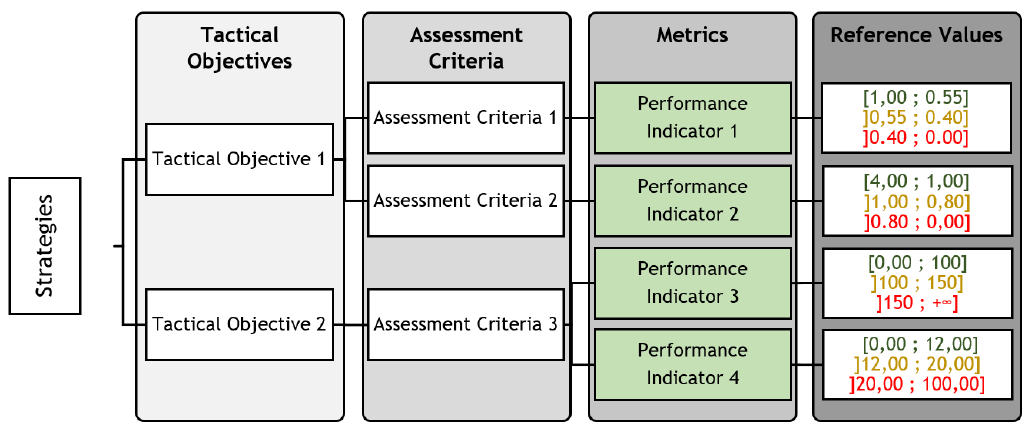
Figure 2: Definition of tactical objectives, assessment criteria and